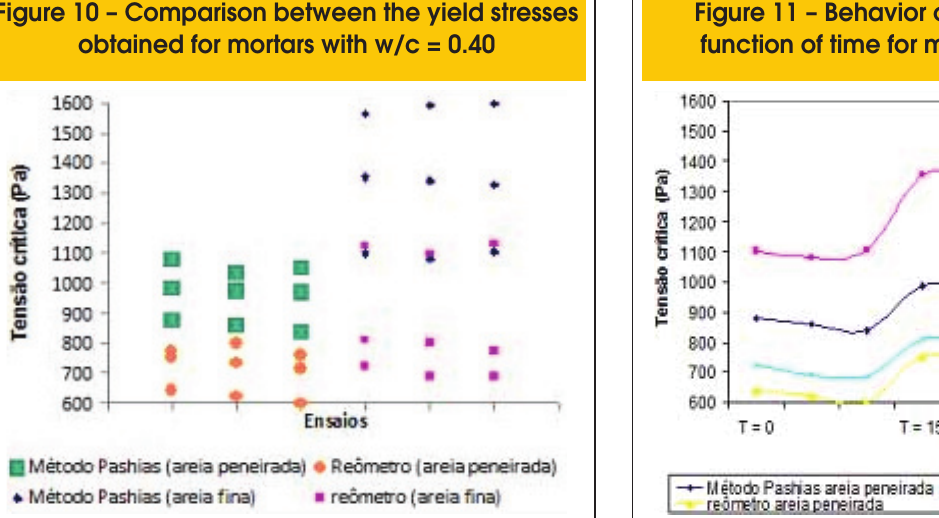
Figure 10 – Comparison between the yield stresses obtained for mortars with w/c = 0.40